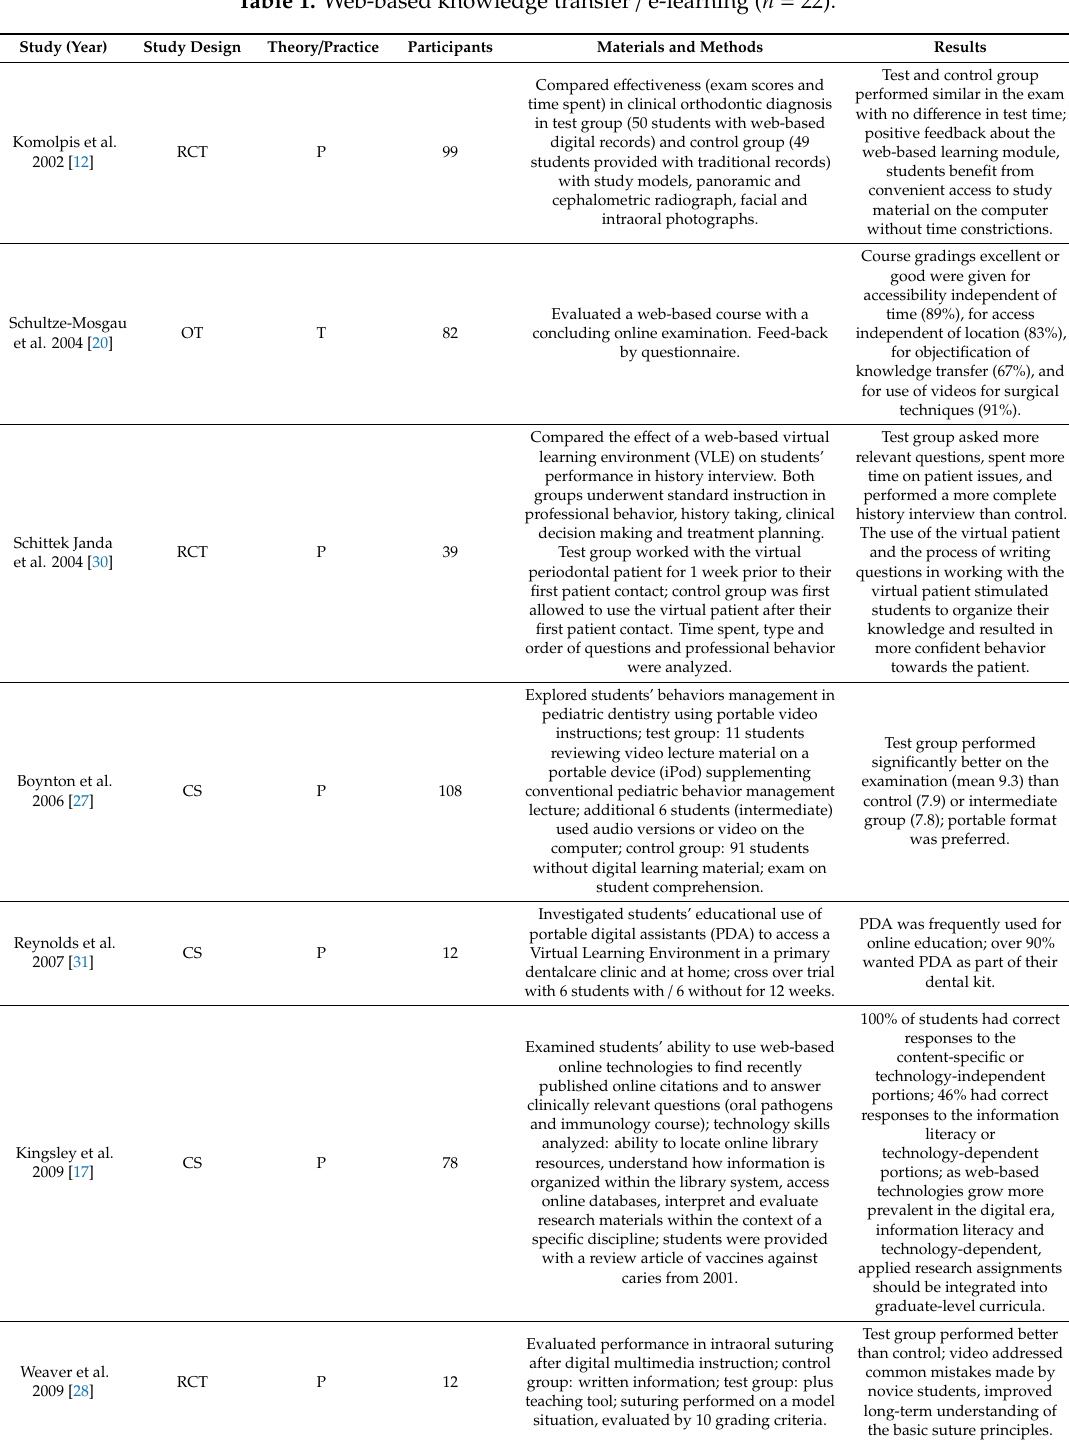
Table 1. Web-based knowledge transfer / e-learning ( n =